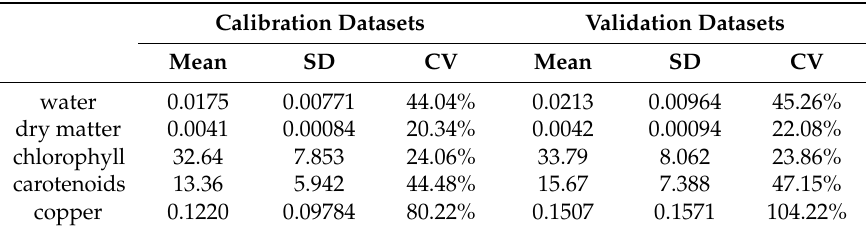
Table 2. Mean, standard deviation (SD), and coefficient of variation (CV) of datasets for calibration and validation (water: cm; dry matter: g/cm 2 ; chlorophyll, carotenoids, and copper: µ g/cm 2